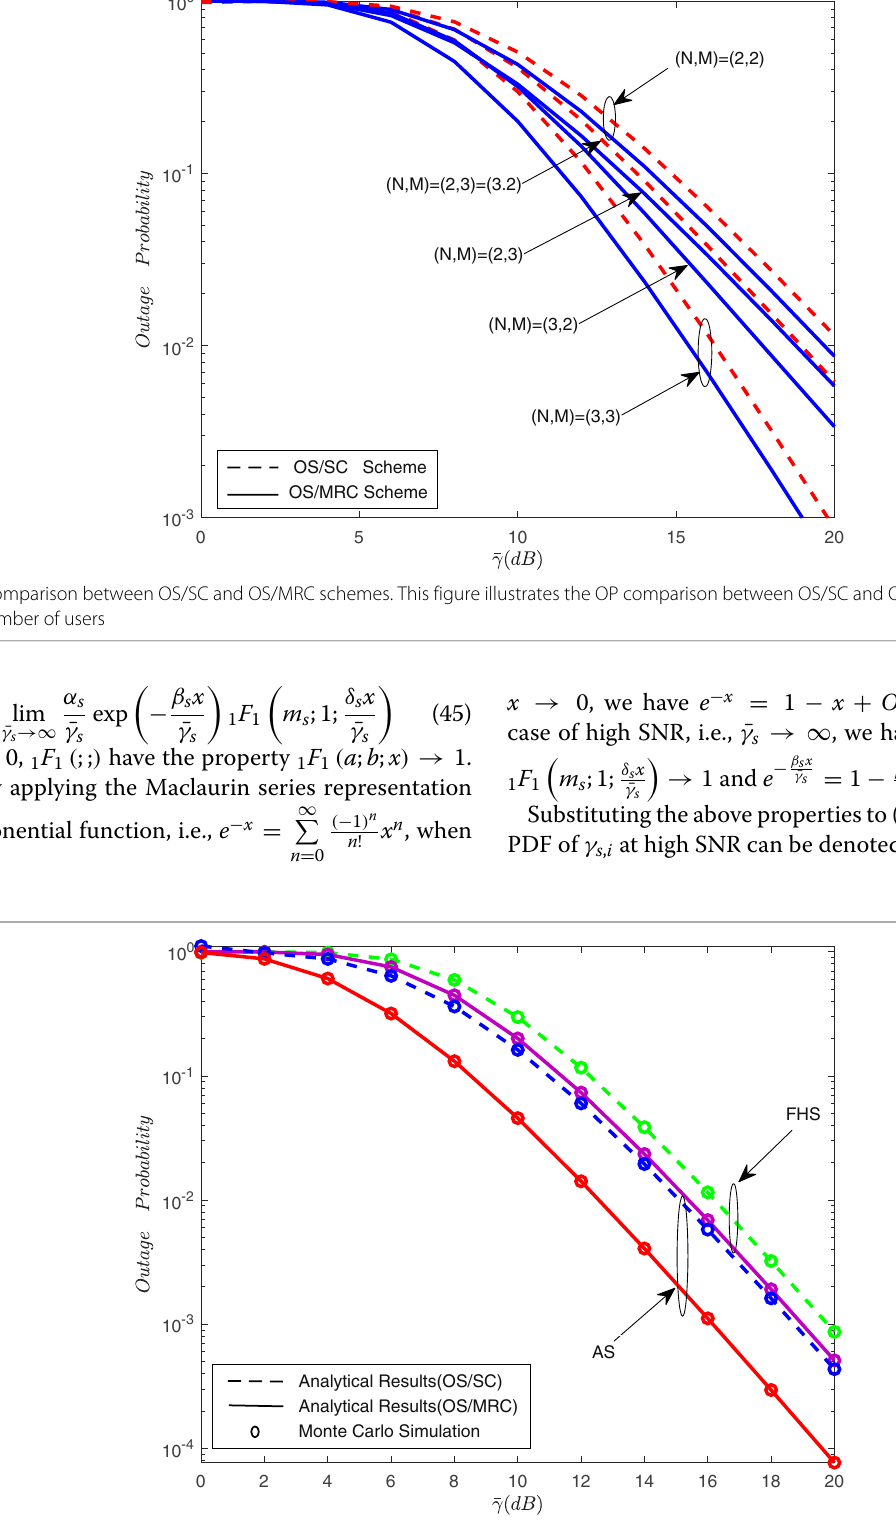
Fig. 6 OP against ¯ γ in different fading scenarios. This figure shows the OP against ¯ γ with ( N , M ) = ( 3,3 ) , where all R-D links follow FHS, while the S-R links experience FHS and